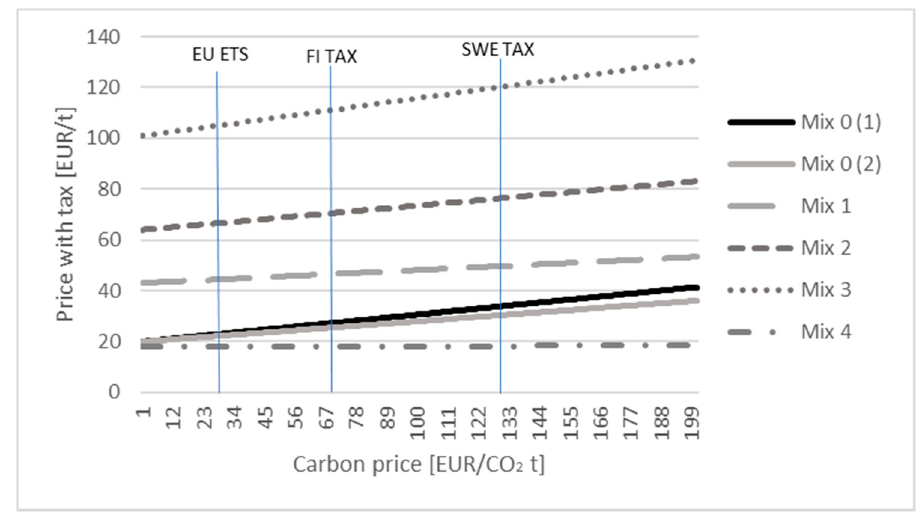
Figure 5. Cost prices of different materials with hypothetical carbon taxes [EUR/t].